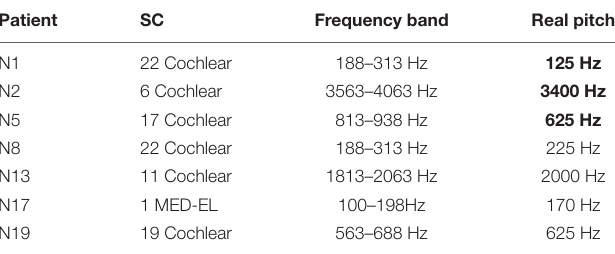
TABLE 3 | Results of the pitch matching